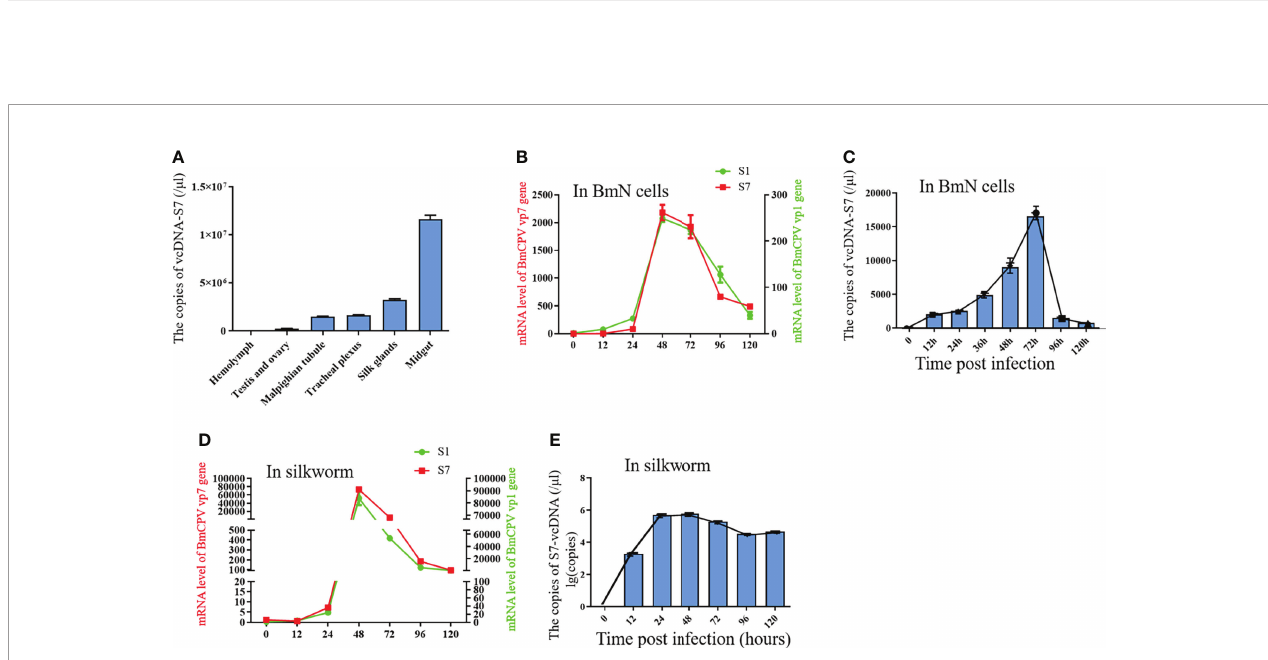
FIGURE 4 | The expression pattern of vcDNA-S7. (A) The express pattern of vcDNA-S7 in different tissues of BmCPV infected silkworm. (B) mRNA levels of BmCPV vp1 and vp7 genes in BmCPV infected BmN cells at different stages were determined by real-time PCR. (C) copies of vcDNA-S7 in BmCPV infected BmN cells at different stages were determined by real-time PCR. (D) mRNA levels of BmCPV vp1 and vp7 genes in BmCPV infected silkworm midgut at different stages were determined by real-time PCR. (E) copies of vcDNA-S7 in BmCPV infected silkworm midgut at different stages were determined by real-time PCR (n=3).